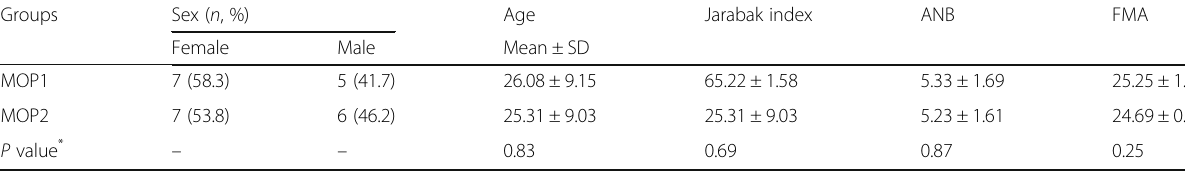
Table 1 Sex, age, and cephalometric characteristics of the current sample Groups